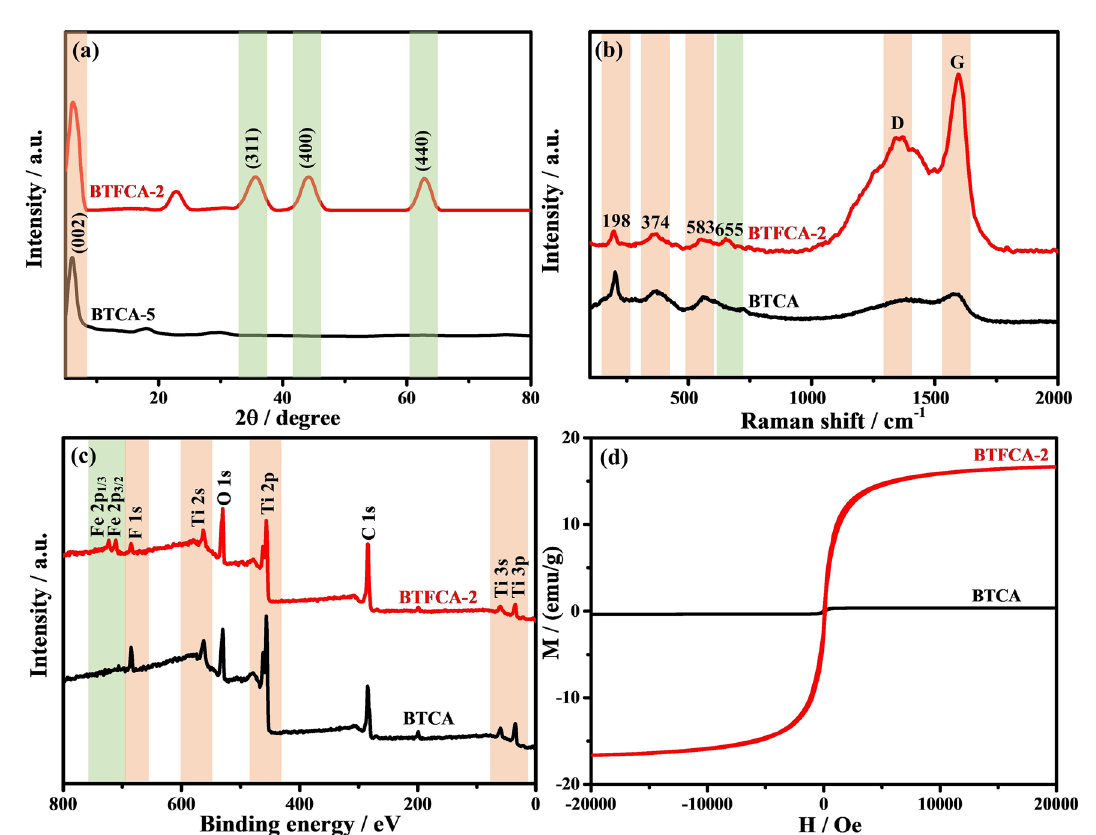
Fig. 2 a XRD, b Raman, c XPS spectra and d hysteresis loops of BTCA and